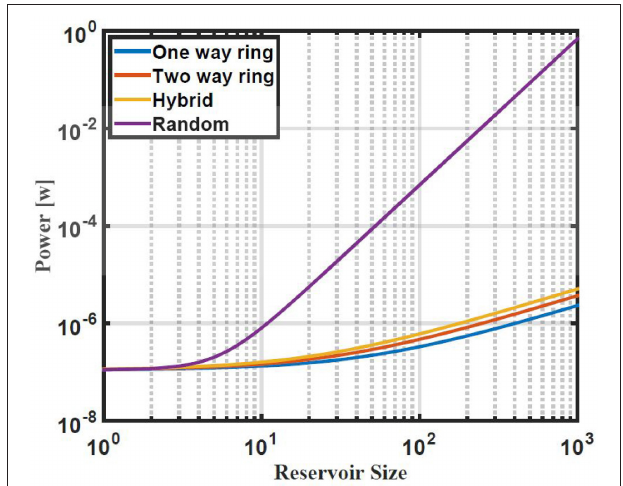
FIGURE 15 | Power consumption vs. reservoir size of four ESN topologies: one way ring, two way ring, hybrid, and random on log scale plot. The one way ring topology has lower power consumption compared to the other topologies while the random topology has higher power consumption compared to the other topologies.